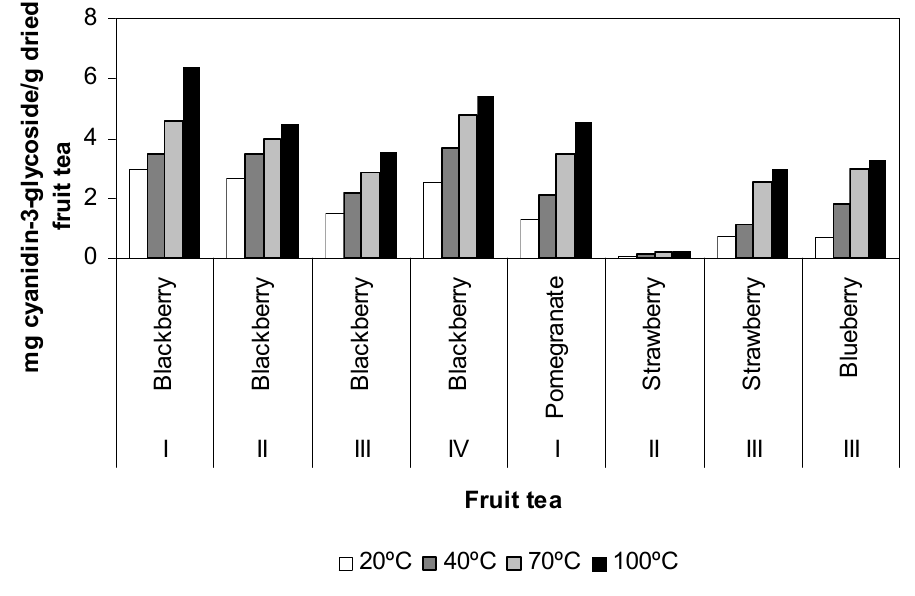
Figure 3. Total anthocyanin content of fruit tea samples affected by